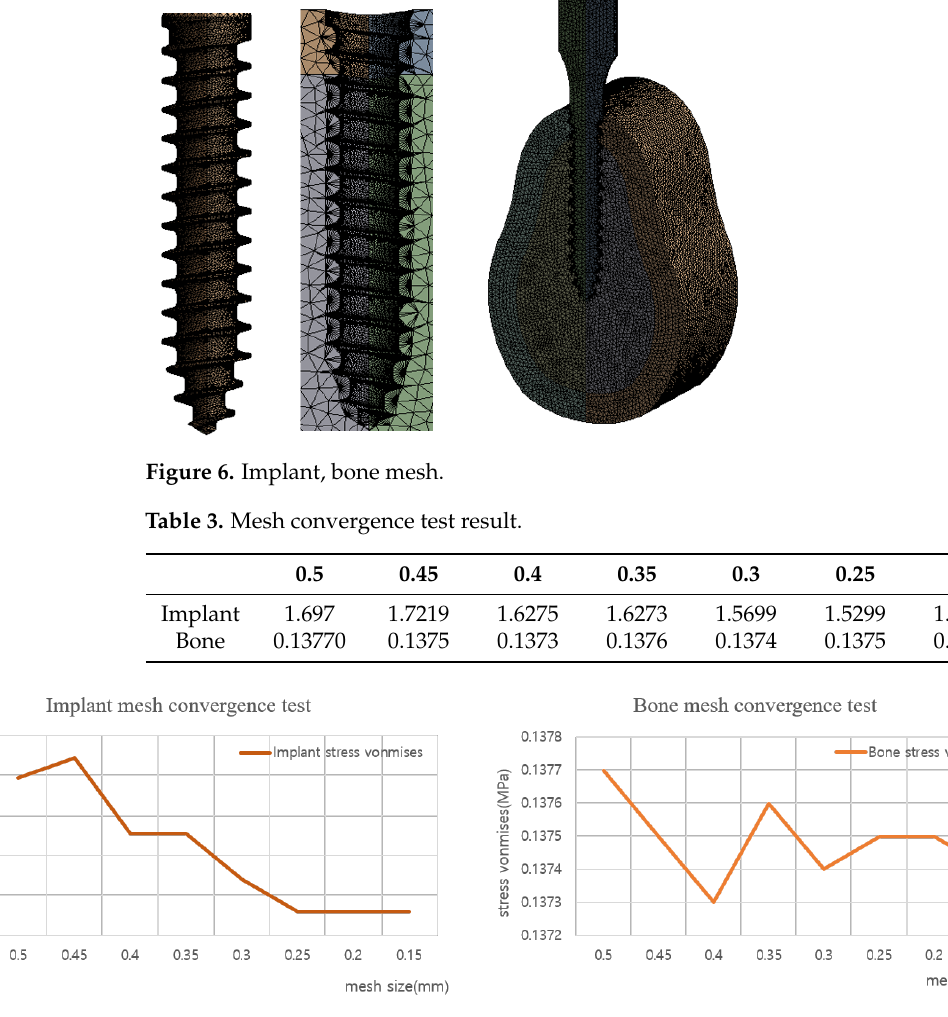
Figure 7. Chart of bone and implant mesh convergence